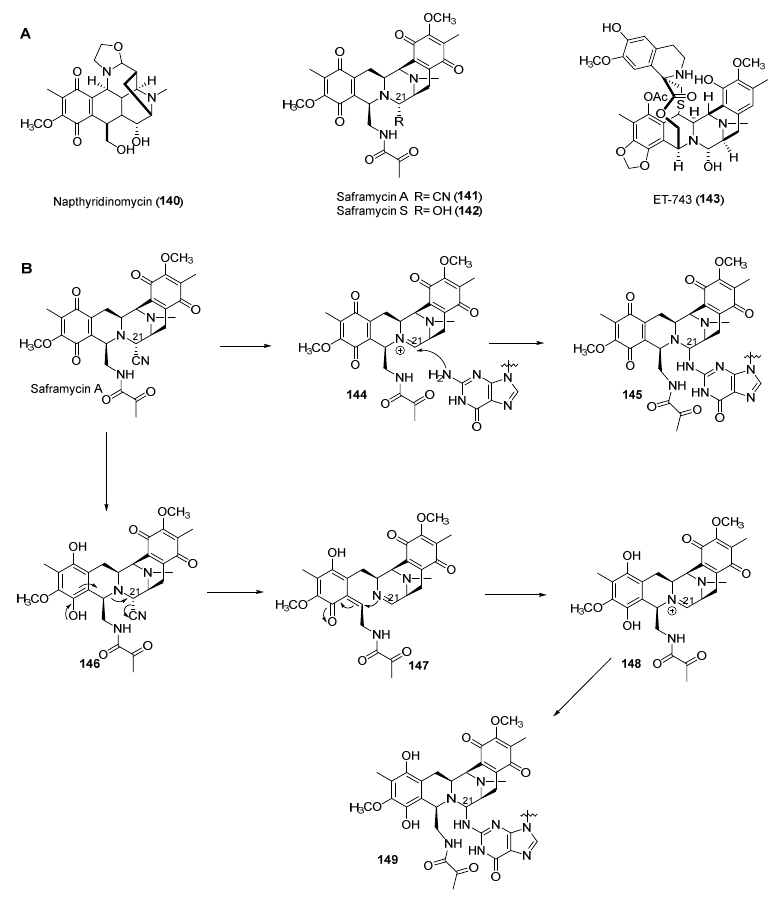
Figure 17. ( A ) Chemical structures of tetrahydroisoquinoline family. ( B ) Proposed mechanism of DNA alkylating by saframycin A.